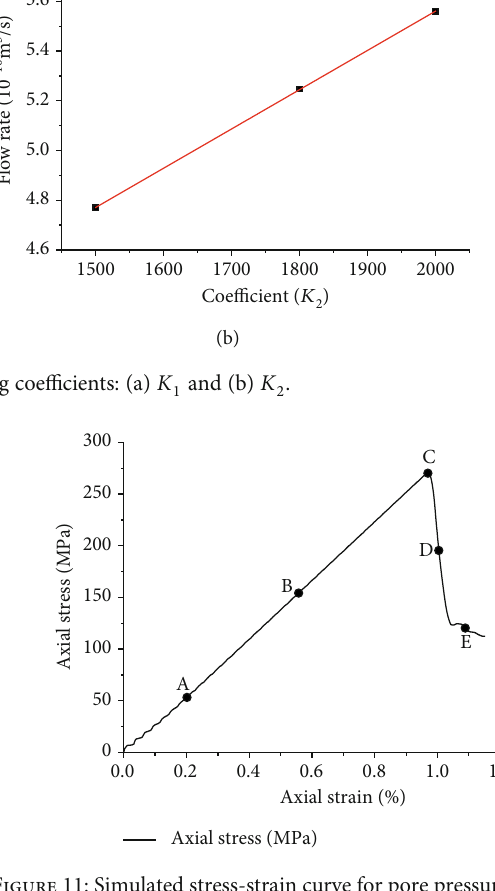
Figure 10: Simulated stress-strain curves for di ff erent pore pressures under 20 MPa con fi ning pressure.